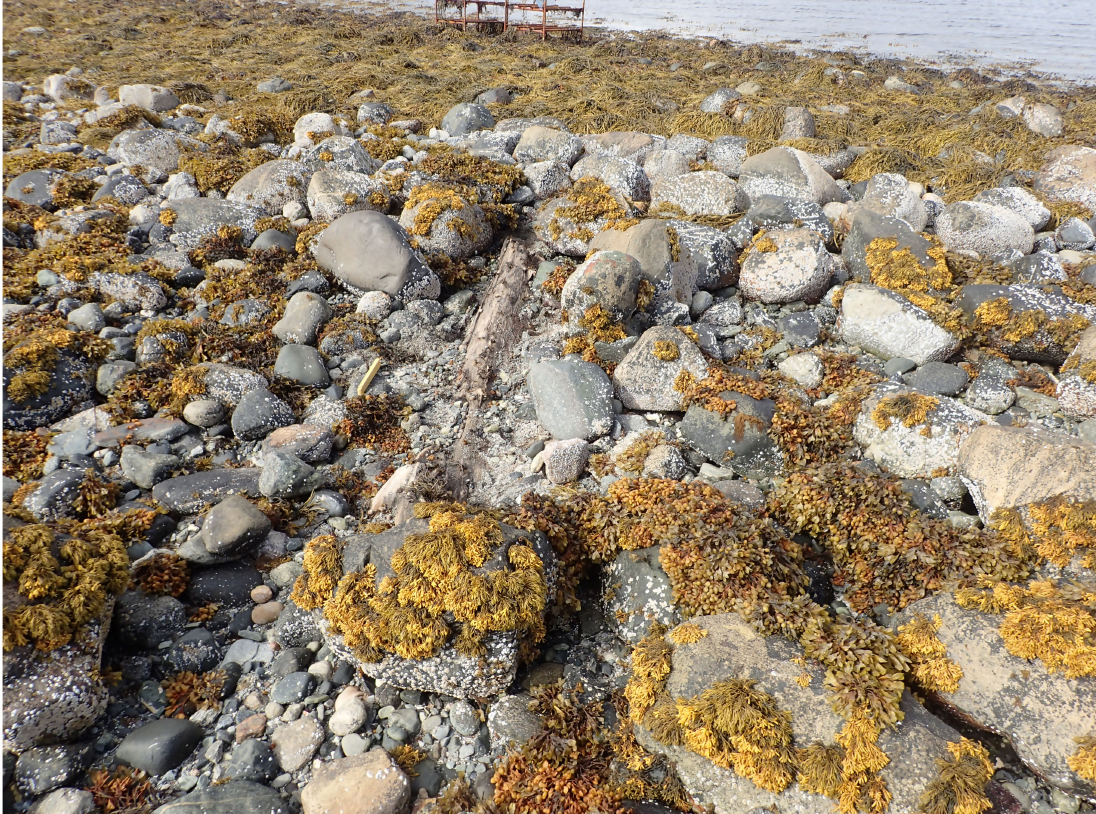
Figure 6. North facing picture showing the location of part of the King Øystein’s harbour’s structure in the intertidal zone which poses challenges of protection and management. The log in the centre of the image is 1.25 m in length and it was originally a part of the base of one of the wooden caissons that constituted the breakwater. Photo: Fredrik Skoglund, NTNU University